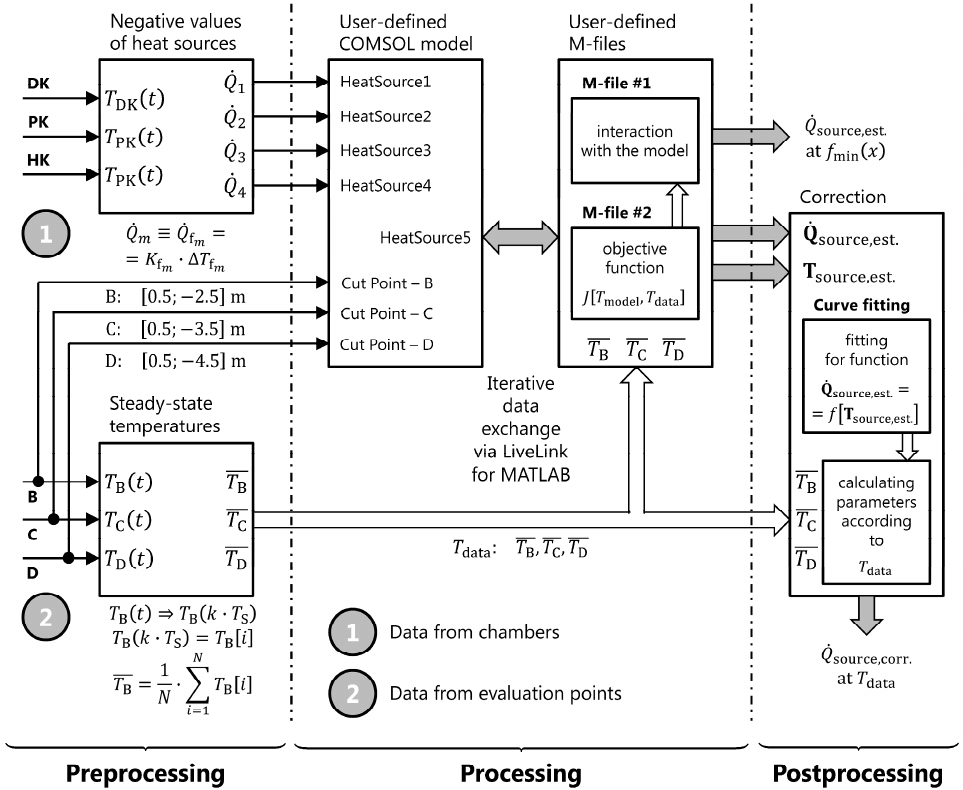
Figure 2. Concept of the solution of the stationary job – block scheme and data flow diagram of the preprocessing (treating input data from chambers and evaluation points), processing (iteration